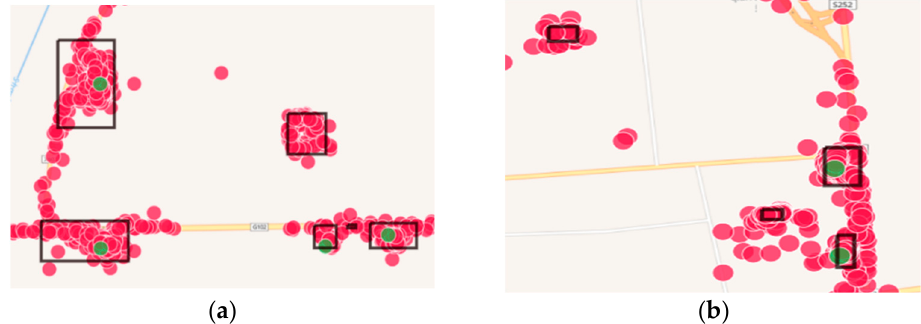
Figure 5. Partial map of the refueling points in Tangshan. ( a ) Partial map No. 1; ( b ) Partial map No. 2.